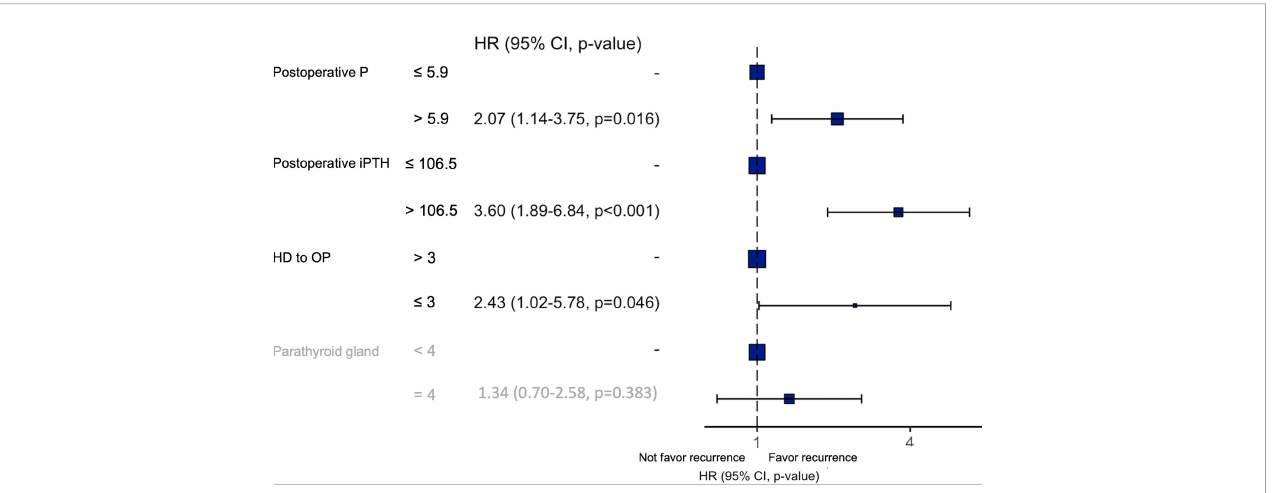
FIGURE 3 Results of the multivariate analysis of risk factors for recurrent SHPT. P, phosphorus; iPTH, intact parathyroid hormone; HD, hemodialysis; OP, operation; HR, hazard